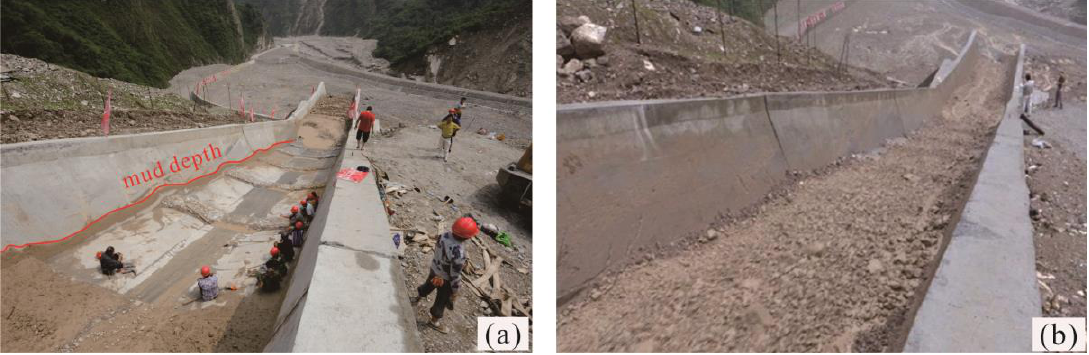
Figure 14. Mud depth and flow pattern of debris flow in the roughening belt section. ( a ) Mud depth on the side wall of sec. B 3 after the 26 July 2012 debris flow; ( b ) flow pattern of the 14 August 2012 debris flow.